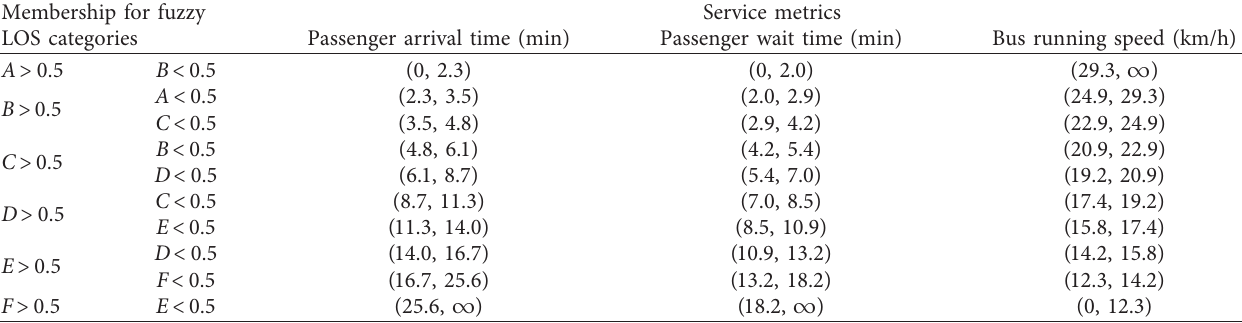
Table 3: BRTfuzzy LOS criteria for the calm passenger group (ranges of service metrics for one primary and one secondary LOS